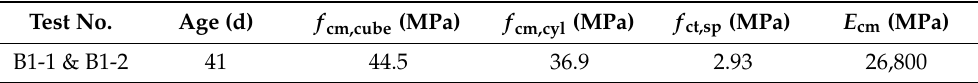
The test setup of the simply supported beam with a cantilever is shown in Figure 3. The load was applied using a 630-kN hydraulic jack. To reduce the local stress concentration, a steel plate (100 × 320 × 10 mm) was used beneath the load application and at the supports. Additionally, a roller was placed under one support to allow for a free horizontal movement. Both supports were able to allow for rotations.